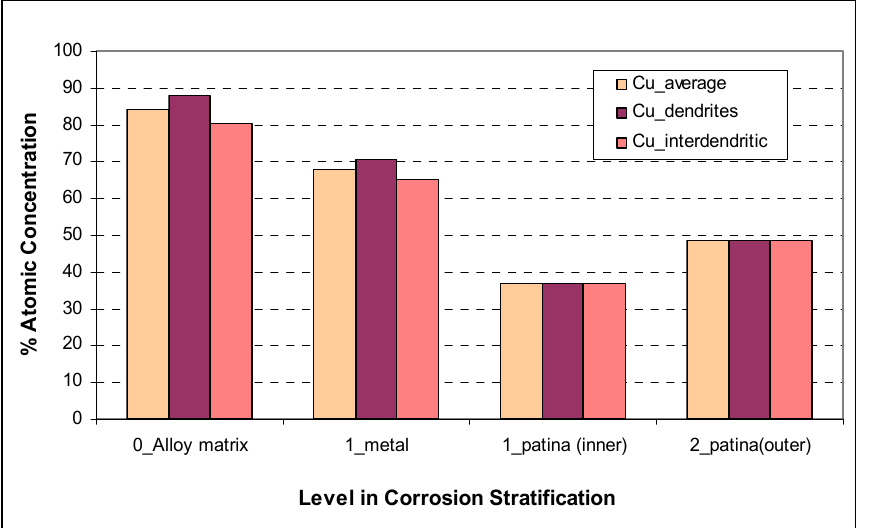
Figure 15. % Cu atomic concentration profile of the corrosion layer stratification in dendritic and interdendritic areas after ZB anodic polarization in 0.1 mol/L NaCl—Based on EDS elemental chemical analyses data (fullframe and spot analyses).